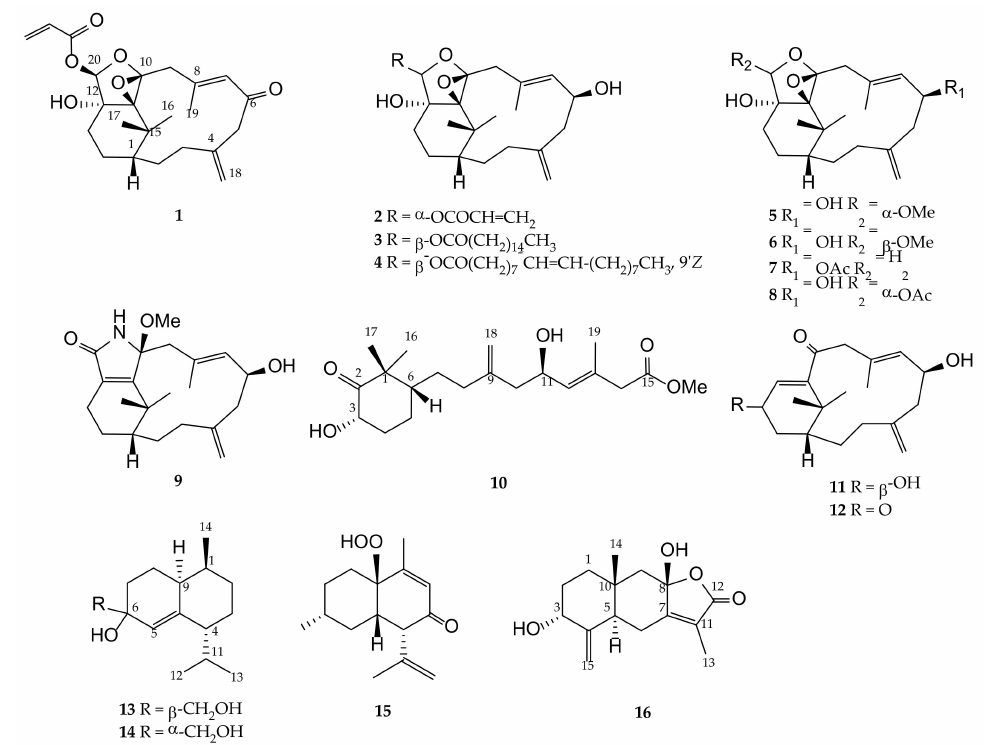
Figure 1. Structures of new compounds 1 – 16